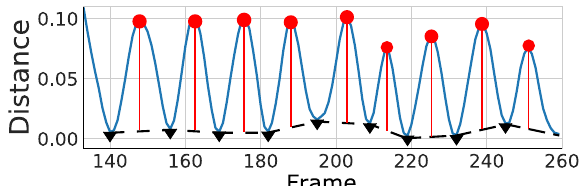
Fig. 7 Peak detection illustration. The amplitude of an action is measured as the vertical distance from a peak (red dot) to the linear interpolation between troughs (black